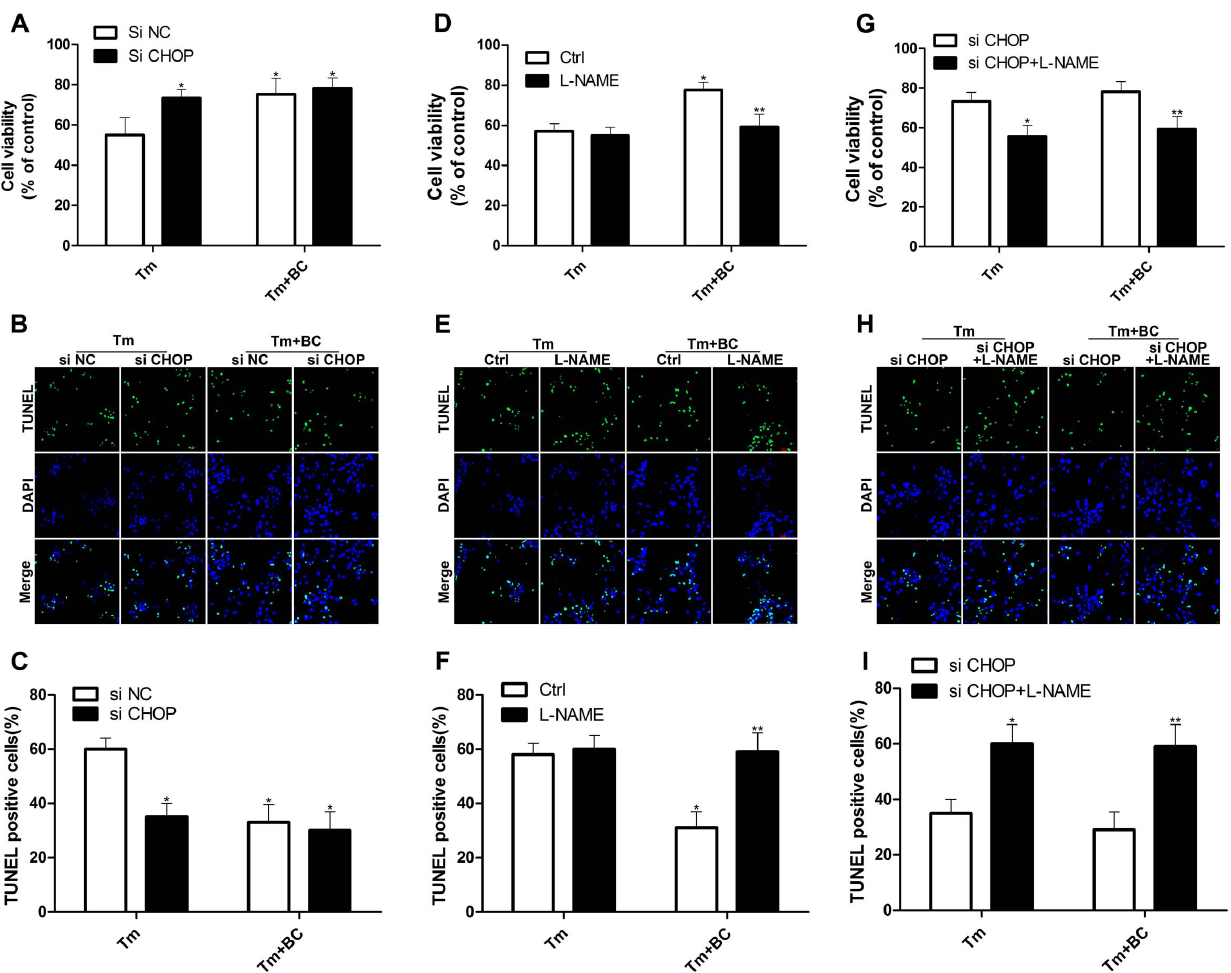
Figure 6. CHOP-eNOS pathway in baicalin mediated protective role. Cardiomyocytes were transfected with or without siRNA for 24 h, and then stimulated with Tm for 72 h with or without baicalin (BC, 25 m M) and L-NAME (10 m M) pretreatment. Viability was measured by the MTT-assay in cardiomyocytes (A, D, G). Apoptosis was tested by TUNEL analysis (B, E, H). Quantitative analysis of TUNEL-positive cardiomyocytes (C, F, I). A, B, C: *P , 0.05 vs Tm + si NC, n=5; D, E, F: *P , 0.05 vs Ctrl + Tm, **P , 0.05 vs Ctrl + Tm + BC, n=5; G, H, I: *P , 0.05 vs Tm + si CHOP, **P , 0.05 vs Tm + BC + si CHOP, n=5.